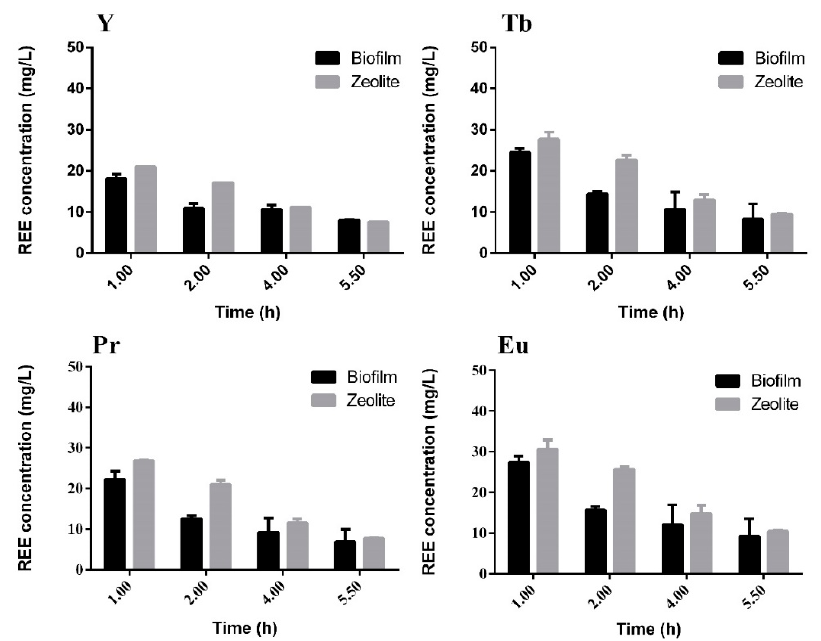
Figure 8. REE recovery from zeolite using HNO 3 at two different concentrations, 0.1 M ( ) and 0.5 M ( ) as leaching agent, using the single-solute adsorption material ( n = 3, X = 2).